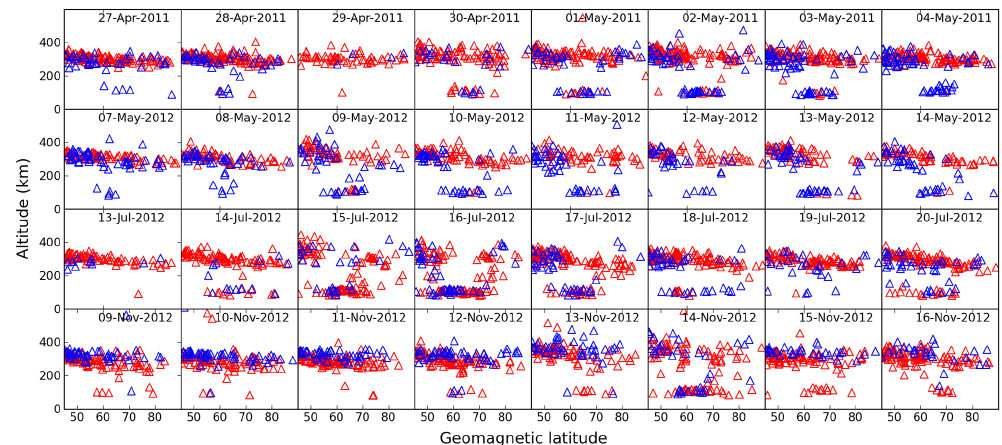
Figure 3. Altitude of peak electron density for the four storm periods studied in this paper. MLT range is 21:00–05:00. All profiles within the MLT range are plotted for Northern (red) and Southern (blue) hemispheres.